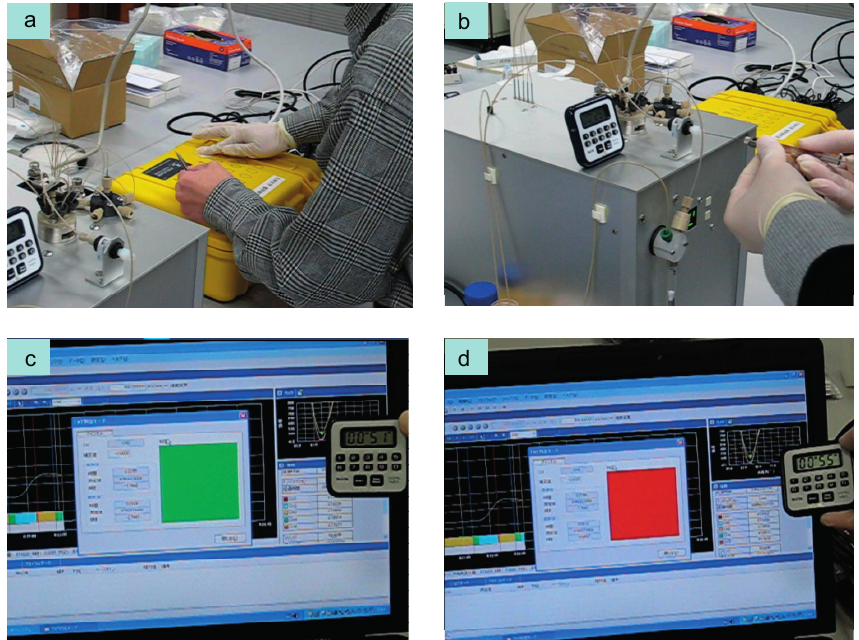
Figure 15. Demonstration process of TNT detection using the first prototype SPR sensor with displacement and wiping methods